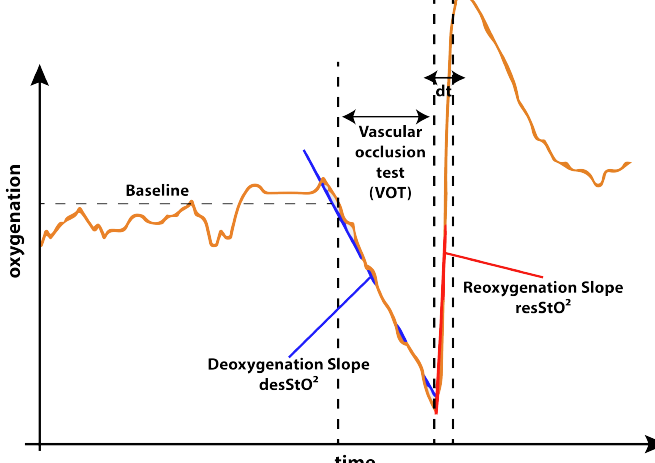
Figure 4. Expected behavior of oxygenation during the occlusion experiment. As described by Futier et al. [50] in the not occluded phase of the experiment a stable baseline with minor fluctuations is expected. As soon as the blood flow is occluded during the vascular occlusion test (VOT), the oxygenation decreases following a deoxygenation slope. As soon as the cuff is released the reoxygenation with an overshoot of oxygenation occurs. The slope providing a way of quantification of the reoxygenation. The time from cuff release to the reoxygenation overshoot peak is quantified as dt . After this the oxygenation curve returns back to